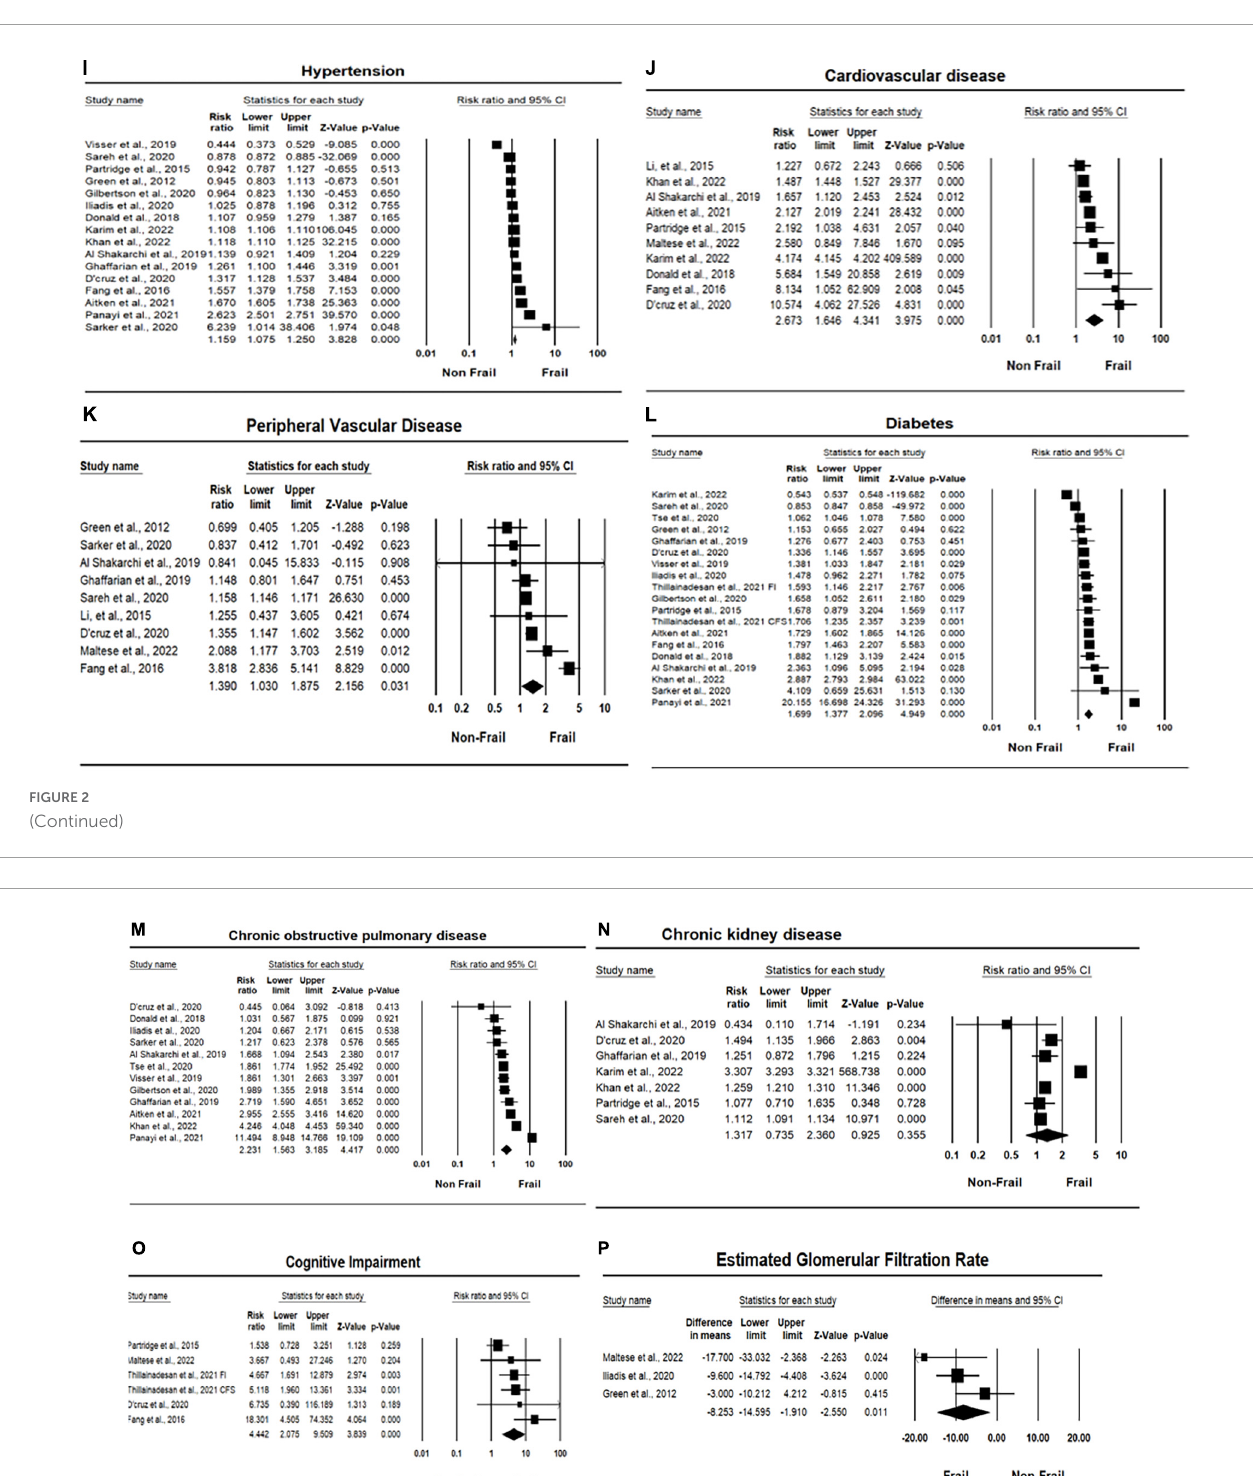
p < 0.001, I 2 < 0.001, p between = 0.001), and patients with other types of wounds (RR = 1.854, CI: 1.650, 2.084,